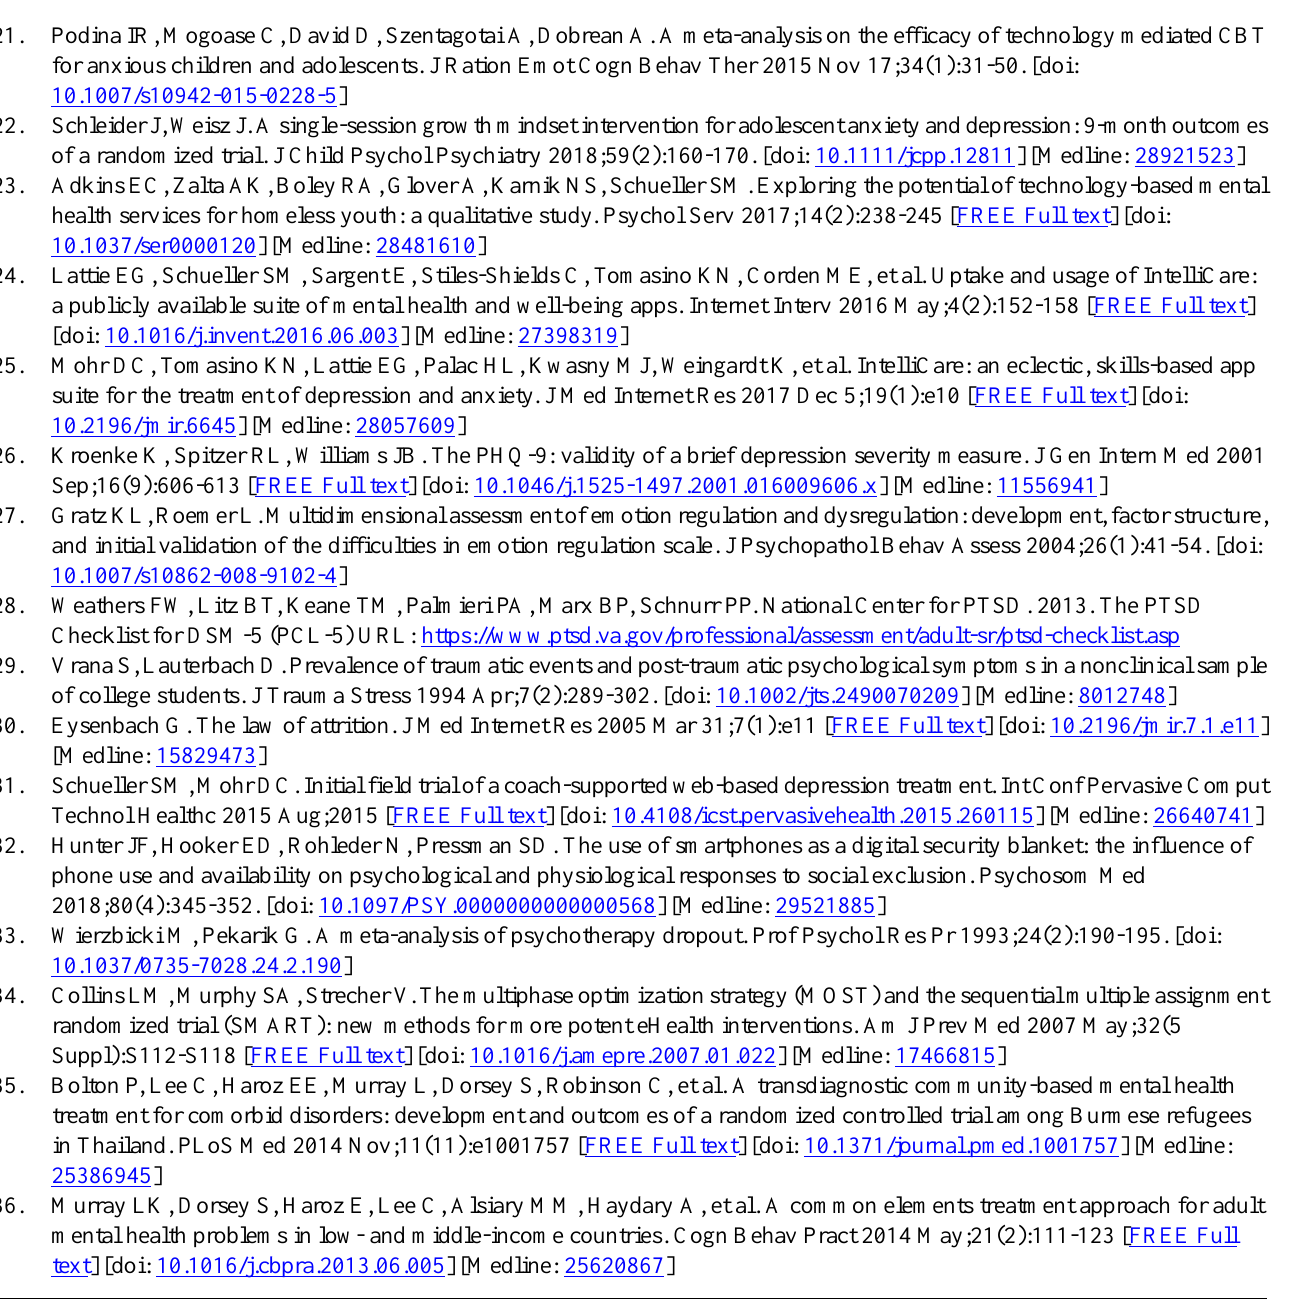
CBT: cognitive behavioral therapy DERS: Difficulties in Emotion Regulation Scale PCL-5: PTSD Checklist for Diagnostic and Statistical Manual of Mental Disorders-5 PHQ-9: 9-item Patient Health Questionnaire PTSD: post-traumatic stress